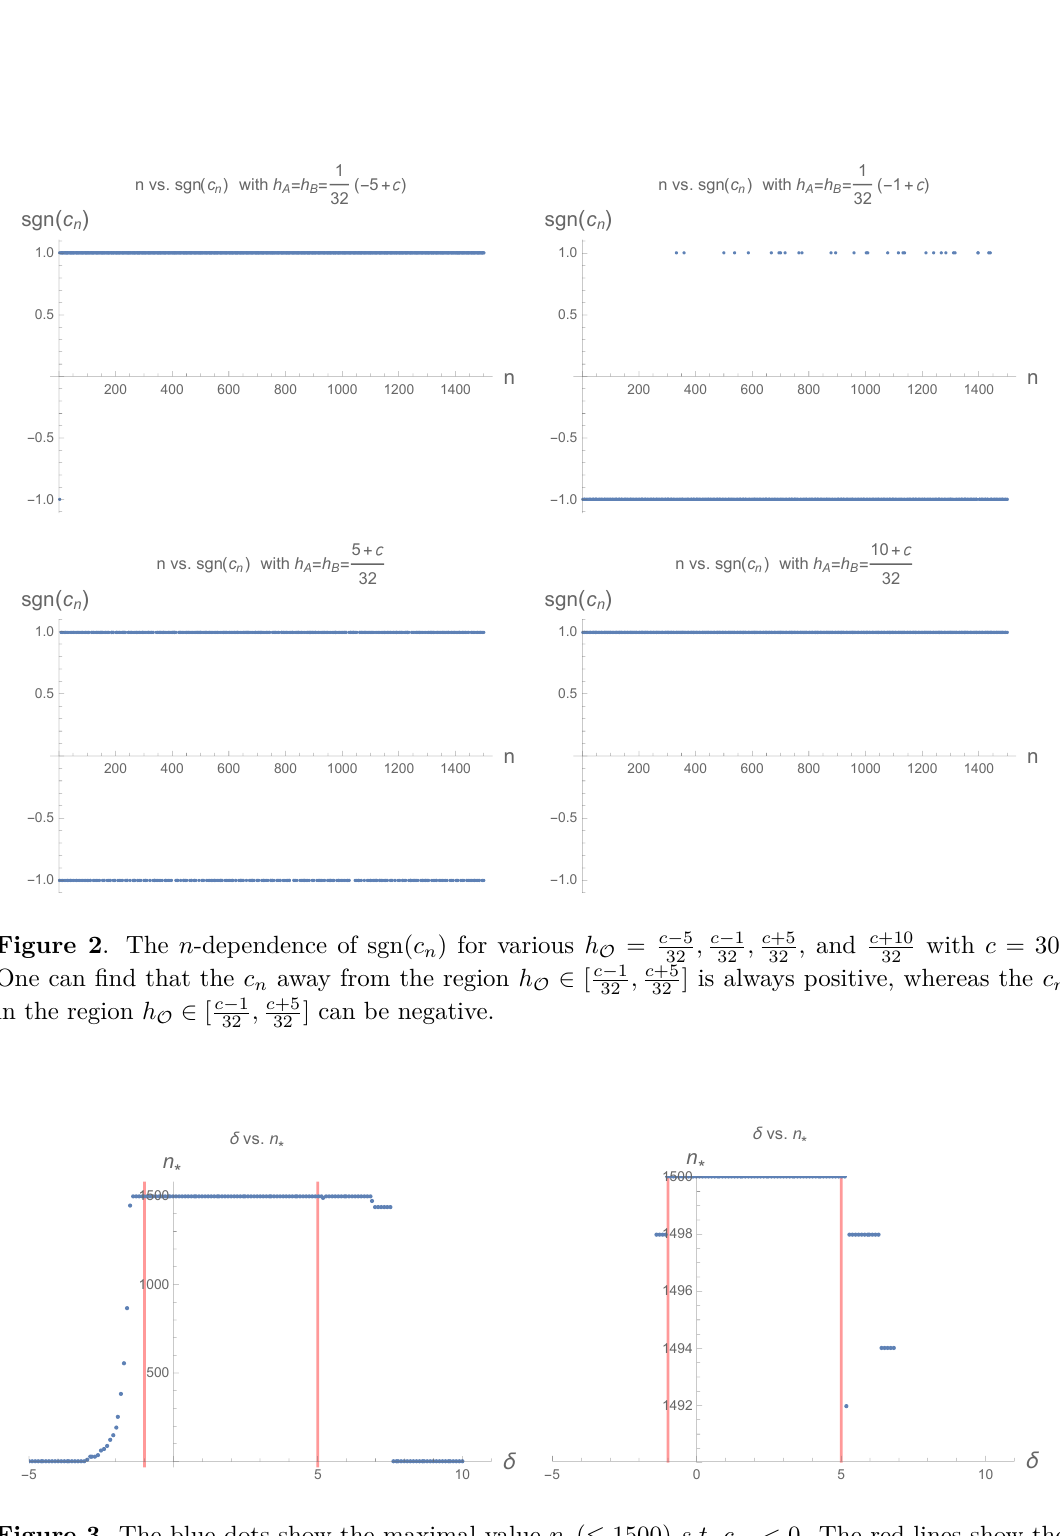
Figure 3 . The blue dots show the maximal value n ∗ ( ≤ 1500) s.t. c c special values δ = − 1 , 5 . Here we fix c = 30 and define c + δ version of the left figure. One can find the plateau in the region δ ∈ [ − 1 , 5] . Note that the upper bound n = 1500 just comes from the limitation of our machine power. We expect that one can see the plateau in δ ∈ [ − 1 , 5] more clearly if we take higher n terms into